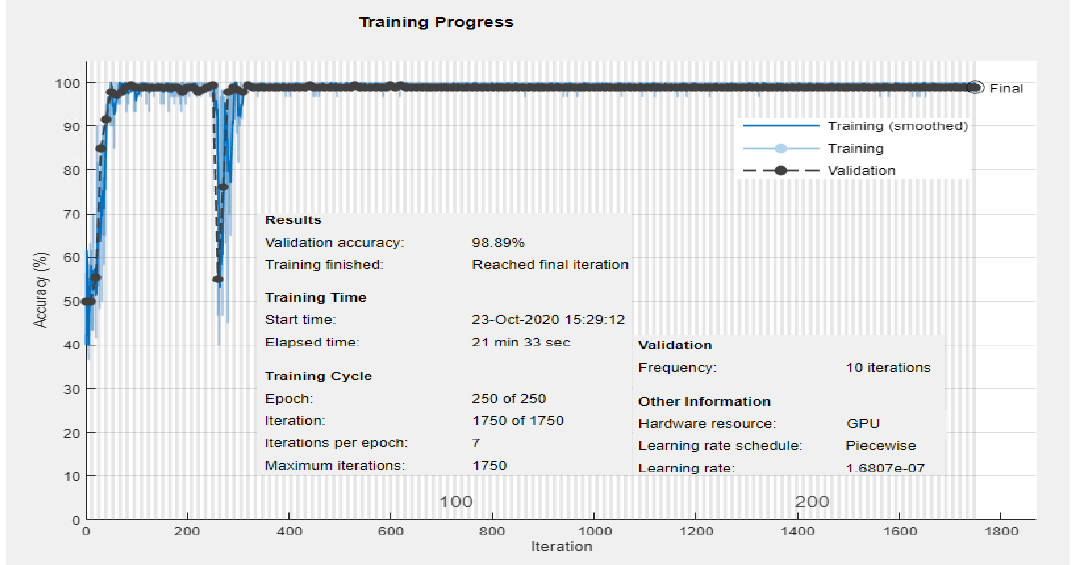
Figure 8. Experiment 1: Training and validation accuracy progress for two classes: Normal and Abnormal using DS1.